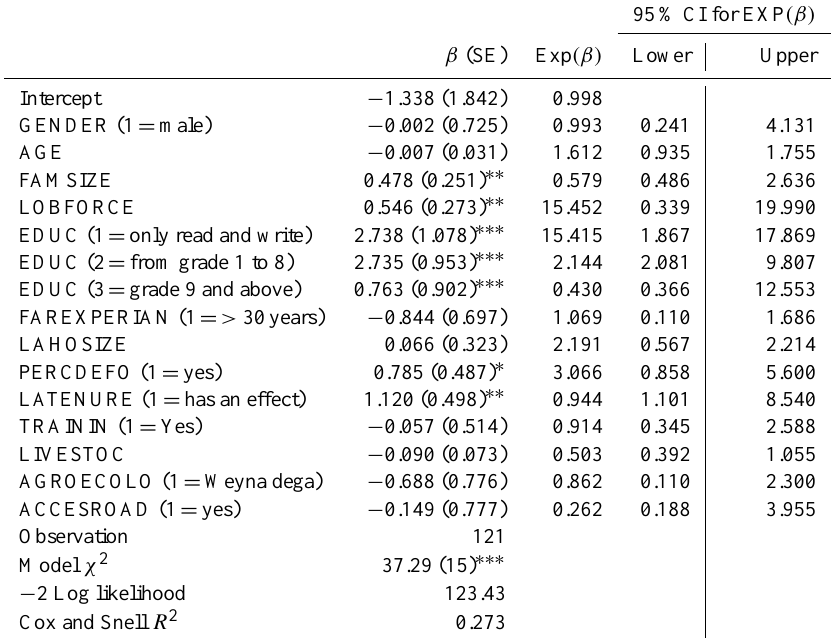
Table 4. Logistic regression results for predicting whether trees are planted by land users using 13 predictors as independent